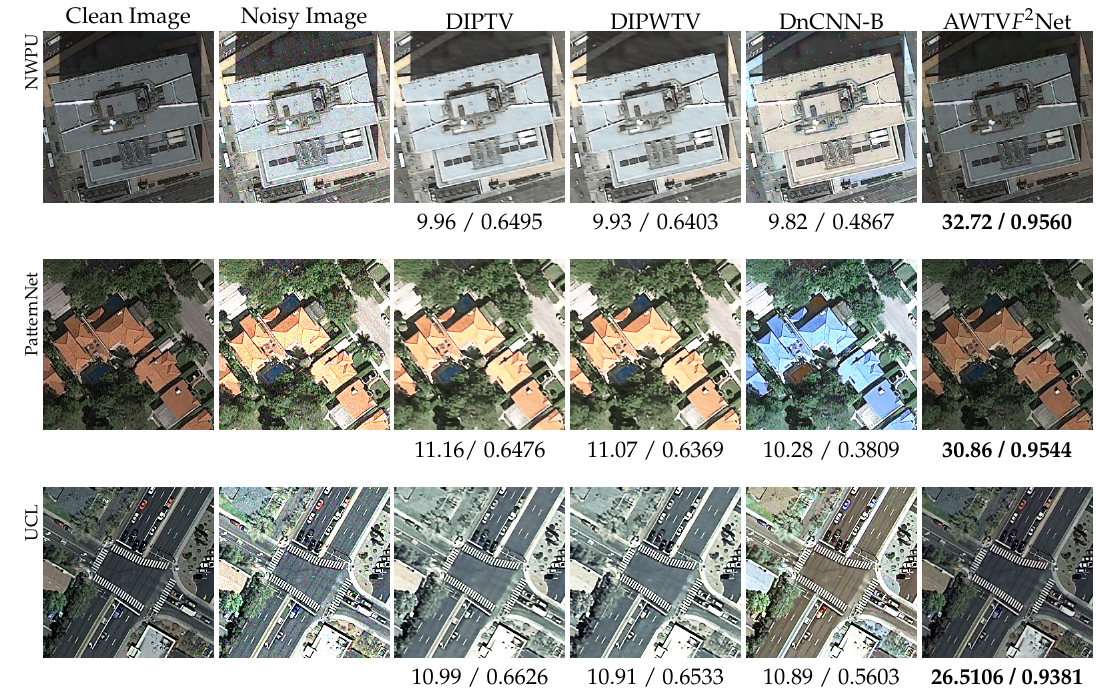
Figure 15. Restored images distorted by mixture noise of Gaussian and